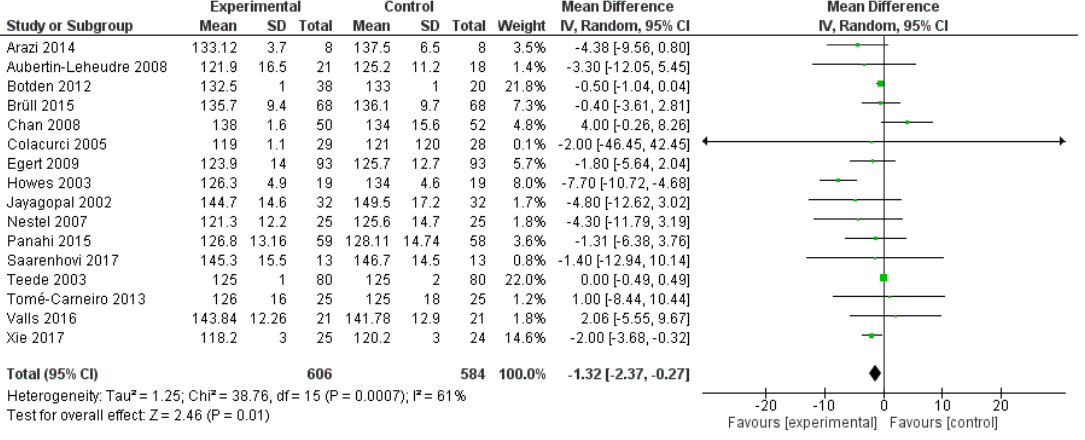
Figure 3. Pooled analysis of association between polyphenol intake and diastolic blood pressure.